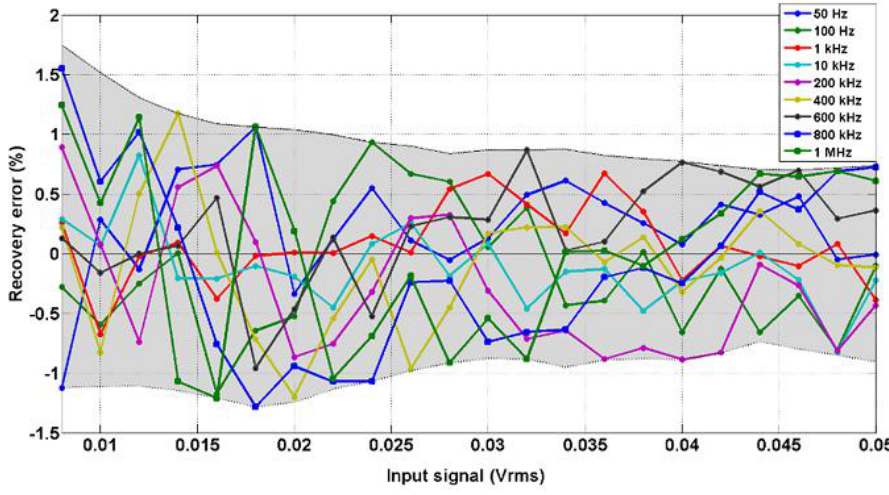
Figure 9. Recovery error vs. input amplitude (square signal) at different frequencies (G = 1). Grey area corresponds to the area between the lower and upper limits of the recovery errors.